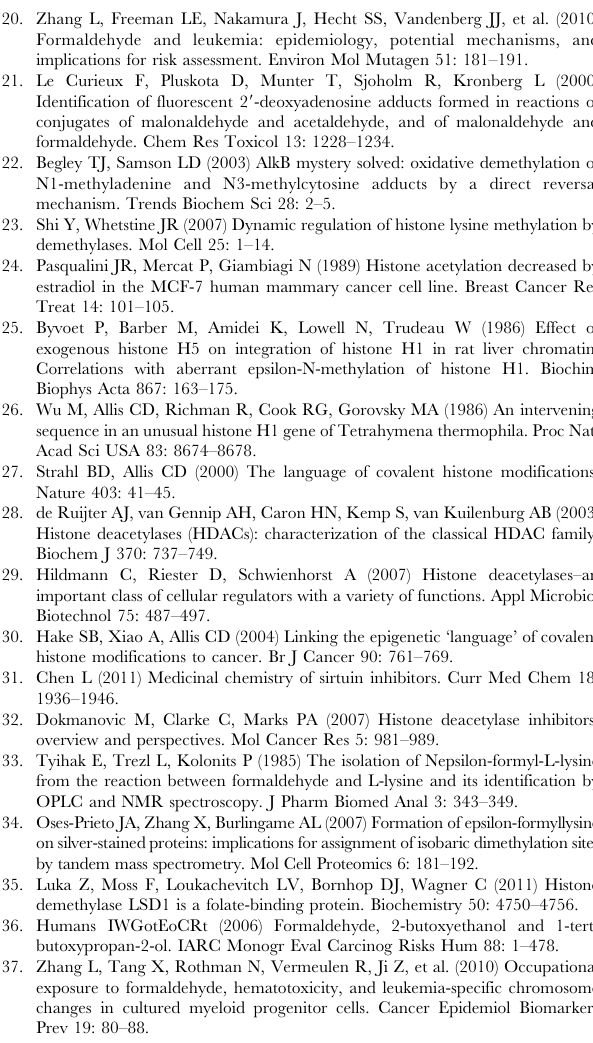
Figure S1 Reversed-phase HPLC fractionation of histone proteins. (A) HPLC elution profile for histones extracted from TK6 cells, as described in Materials and Methods . (B) SDS/PAGE analysis of the HPLC-fractionated proteins shown in panel A. Lanes 1 and 2 are molecular weight markers, while lanes 3 and 4 refer to total histones from TK6 cells and calf thymus, respectively. (TIF) Figure S2 Lysine demethylation is not a source of N 6 - formyllysine in histones. By culturing TK6 cells in customized RPMI medium containing L-Methionine-([ 13 C, 2 H 3 ]-methyl) for 20 days, it was shown that in contrast to predominant heavy isotope labeling of mono-methyllysines ( . 90%), even as early as day 2, the level of N 6 -[ 13 C, 2 H]-formyllysine did not show an increase beyond the natural isotope abundance level ( , 0.7% for [M + 2] ion of N 6 -formyllysine), for any day. (TIF) Figure S3 Examples of product ions for each lysine species monitored, after optimization. In all cases, the highest count was used as the product ion for MRM in triple quadruple mass